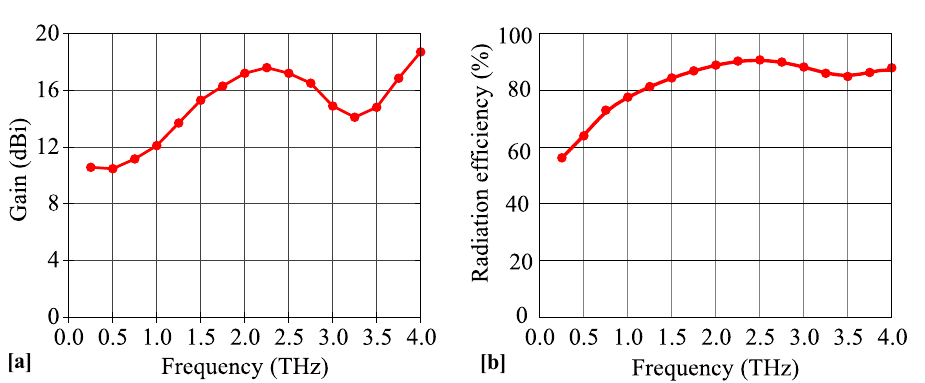
Figure 5. ( a ) Radiation Gain and ( b ) Radiation efficiency of the antenna over the frequency band 0 − 4